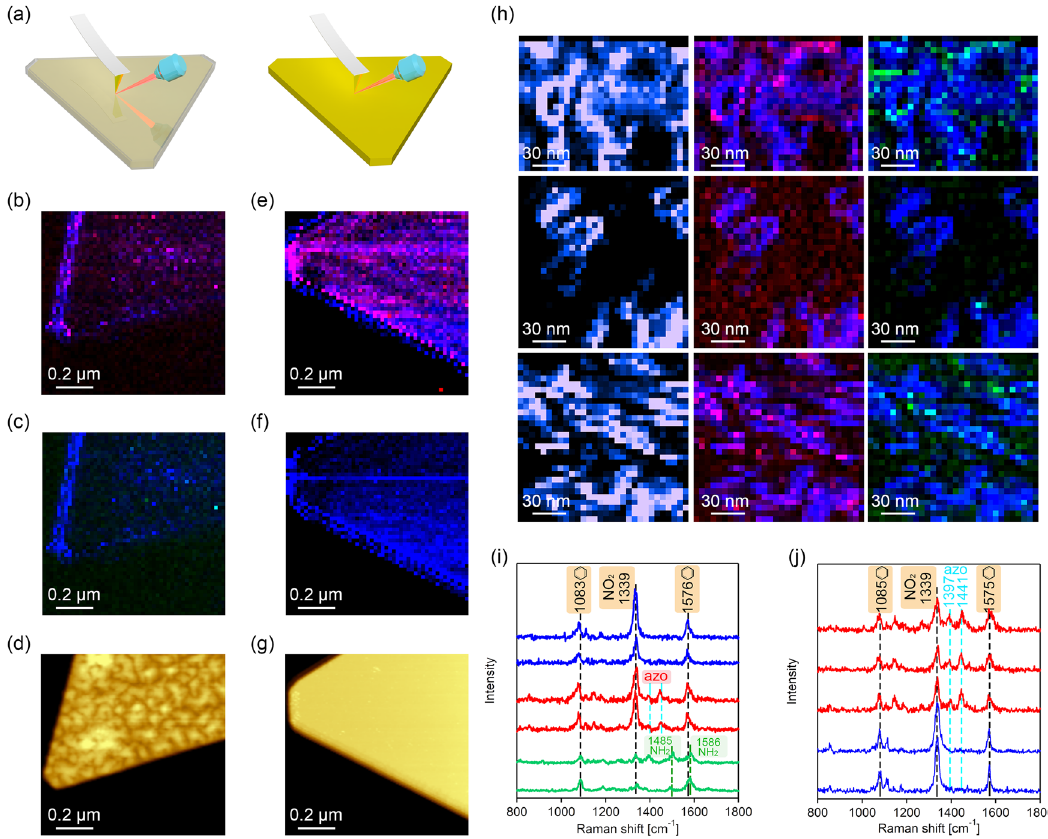
Figure 12: (a) Schematic illustration of TER imaging of Au@Pd (left) and AuMPs (right). (b – c) TERS image of Au@Pd MPs (20 nm per pixel). Intensity of 1339 cm − 1 band (NO 2 vibration) of 4-NBT shown as blue, intensities of 1397 and 1451 cm − 1 (N=N vibration) of DMAB shown as red, and intensities of 1485 cm − 1 (NH 2 vibration) shown in green. (d) Corresponding AFM (bottom) images of Au@Pd MPs. (e – f) TERS image of AuMPs (20 nm per pixel). Intensity of 1338 cm − 1 band (NO 2 vibration) of 4-NBT shown in blue, and intensities of 1397 and 1447 cm − 1 (N=N vibration)ofDMABshowninred.(g)CorrespondingAFM(bottom)imagesofAuMPs.(h)Nanoscaleimages(5nm/pixel)ofAu@PdMPsshowing distribution of intensities of NO 2 vibration, left panels; overlaid NO 2 and N=N vibrations, center panels, and overlaid NO 2 and NH 2 vibration (1485 cm − 1 ), right panels. (i – j) Typical TERS spectra extracted from chemical maps on Au@PdMPs (b, c) and AuMPs (e, f) showing presence of 4-NBT (blue), DMAB (red) and 4-ATP (green)